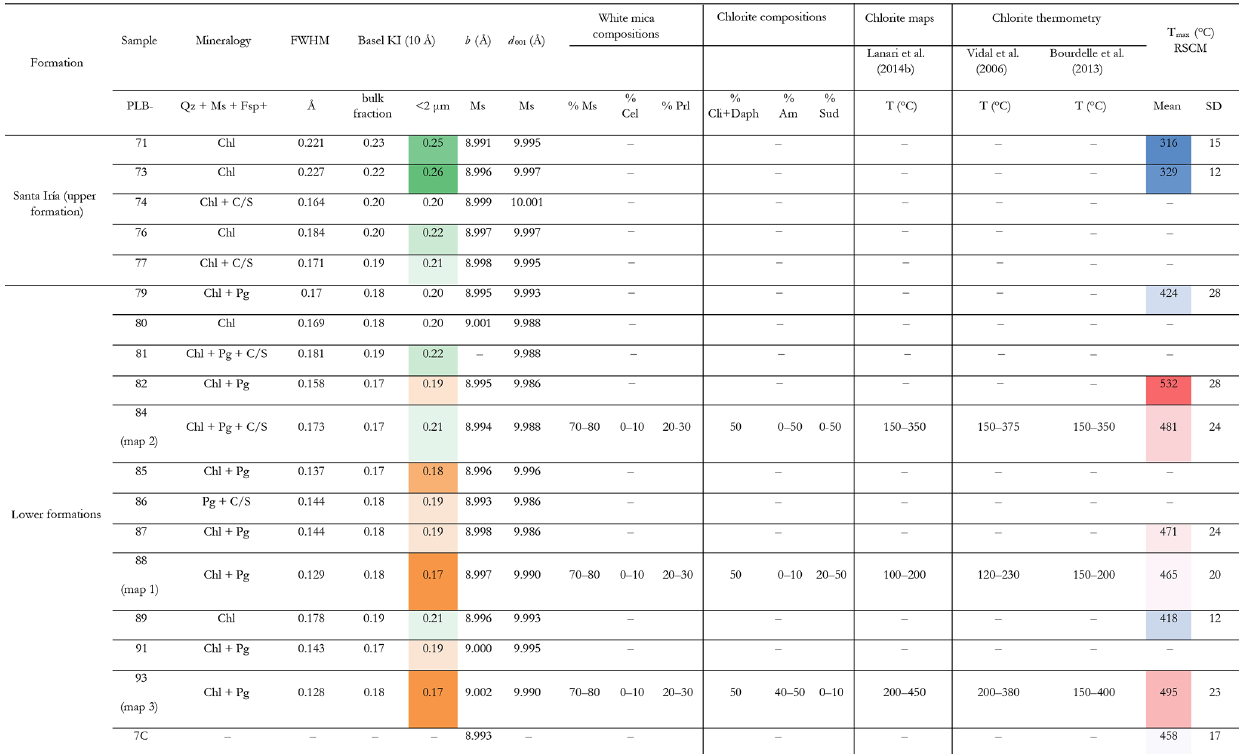
Table 1. Samples and results obtained by XRD (<2µm fraction), white mica and chlorite compositions, temperature ranges from chlorite thermometry, and average RSCM thermometry. Basel KI values and average RSCM temperatures show a relative color-bar scale. Min- eral abbreviations according to Whitney and Evans (2010). Qz: quartz, Ms: muscovite, Fsp: feldspar, Chl: chlorite, Pg: paragonite, C–S: chlorite–smectite mixed layers, Cel: celadonite, Prl: pyrophyllite, Cli + Daph: clinochlore + daphnite, Am: amesite, Sud: sudoite, SD: stan- dard